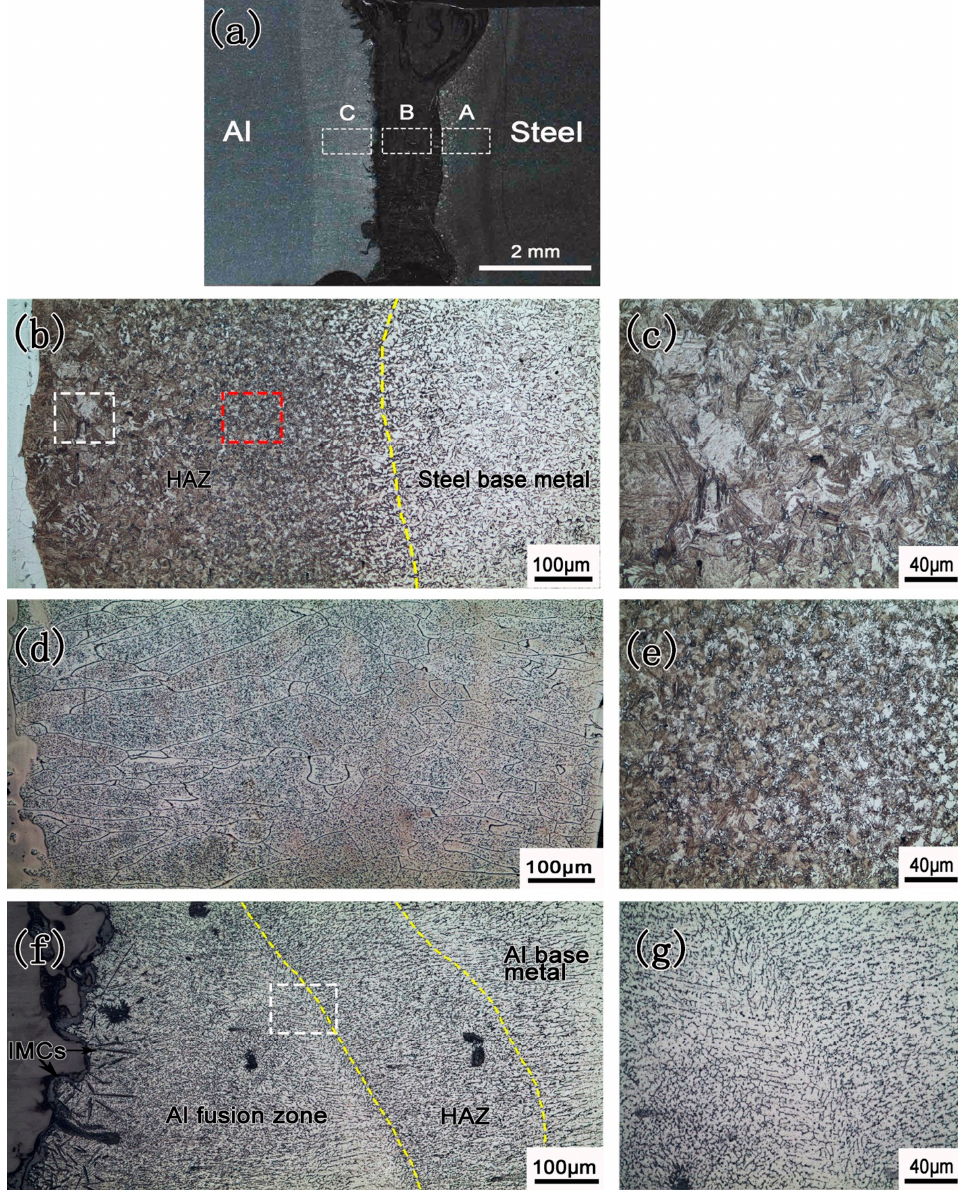
Figure 7. Cross-section microstructure of laser welding–brazing joint of aluminum and steel: ( a ) cross section of joint; ( b ) enlarged zone A in ( a ); ( c ) enlarged zone marked by white dashes in ( b ); ( d ) enlarged zone B in ( a ); ( e ) enlarged zone marked by red dashes in ( b ); ( f ) enlarged zone C in ( a ); ( g ) enlarged zone marked by white dashes in ( f ).